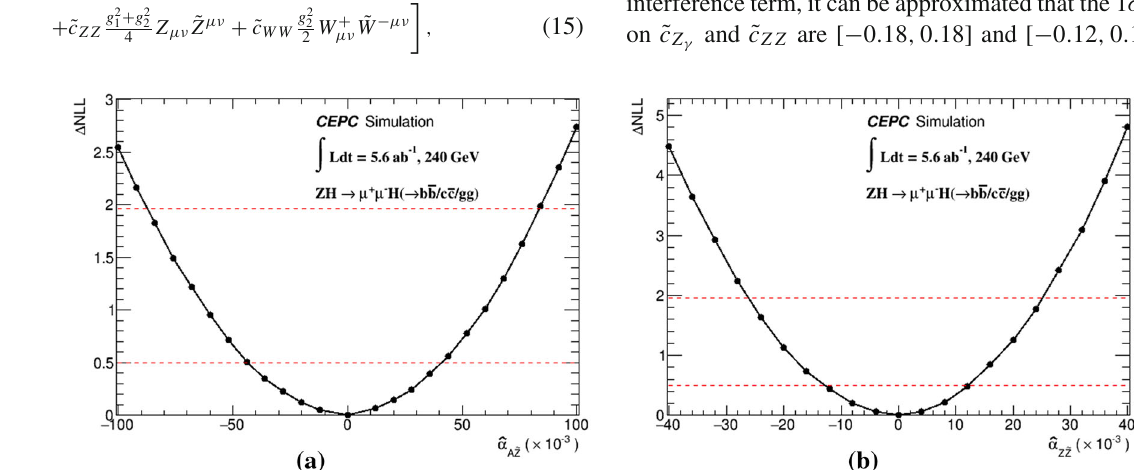
= 0), b (cid:16) NLL curve (fit to ˆ α with (cid:8) α A ˜ Z Z ˜ Z